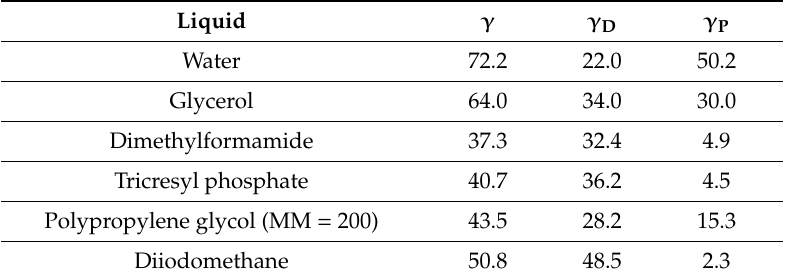
Table 2. Surface energy of the test liquids (mJ / m 2 ) at 25 ◦